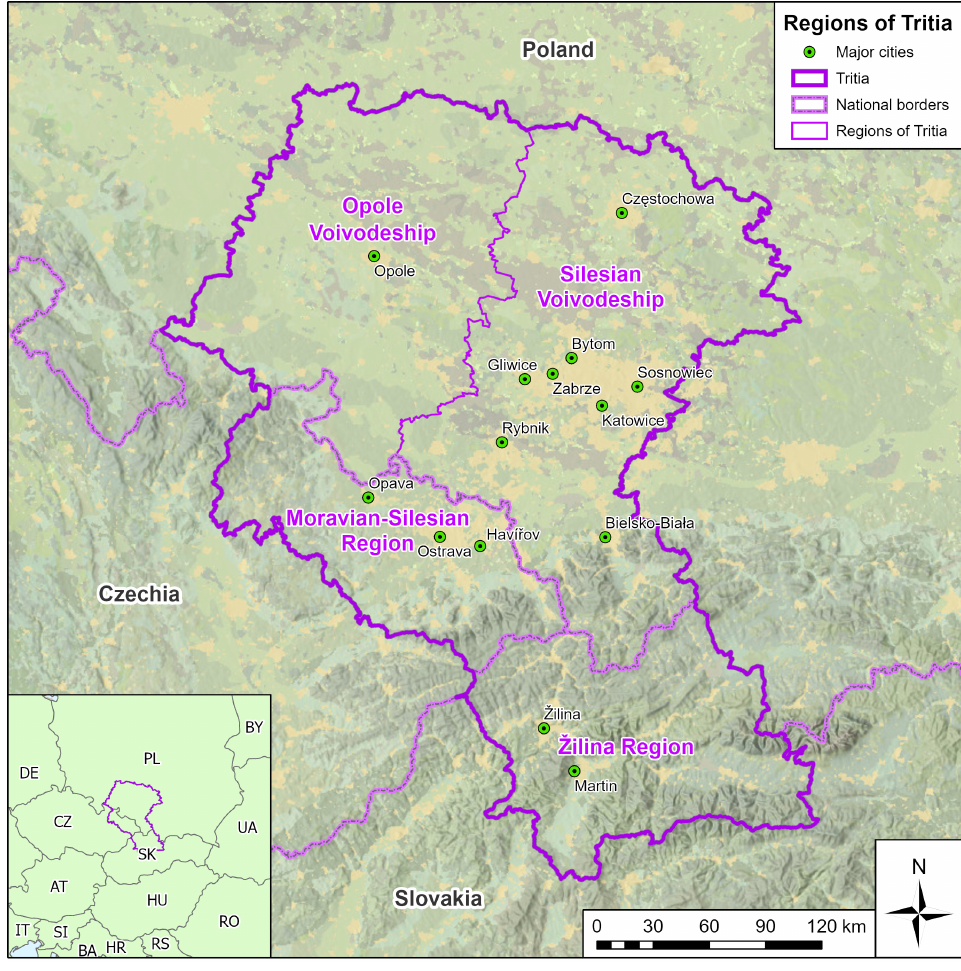
Figure 1. EGTC Tritia regions. The Moravia–Silesian Region is located on the southwestern side of the EGTC Tri- tia. It borders the Silesian Voivodeship in the east, the Opole Voivodeship in the north in the EGTC Tritia area are the Bohemian Massif and the Western Carpathians. Between into the Silesian Lowland in the east and northeast, with the Odra River flowing